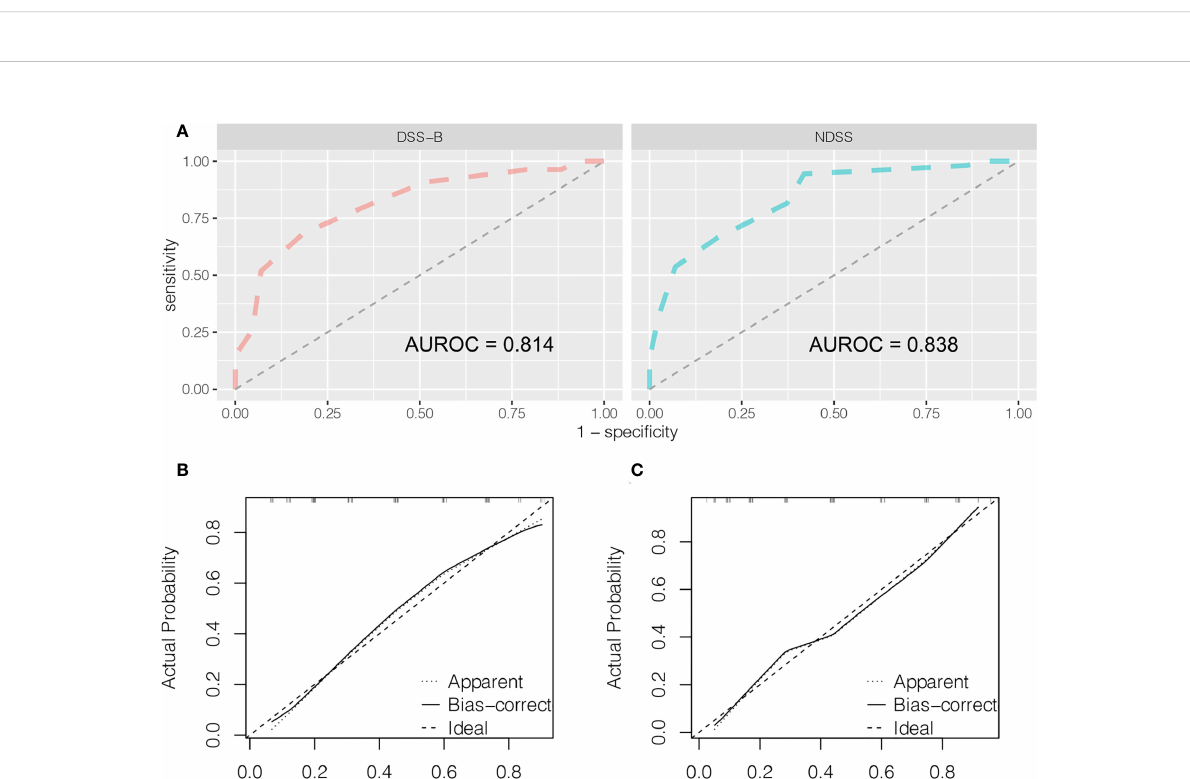
FIGURE 5 Predictive accuracy comparison of DSS-B and NDSS by ROC curve analyses (A) . The calibration curves for predicting surgical dif fi culty by DSS-B (B) and NDSS (C)